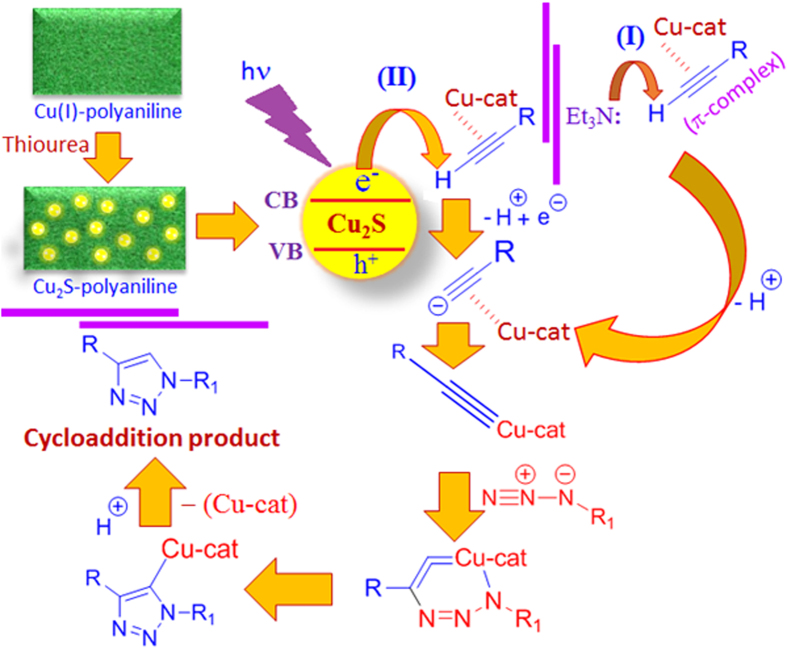
Schematic mechanism for the Cu2S catalysed azide-alkyne cycloaddition reaction in presence of base, Et3N, (I) and under UV or daylight irradiation (II) condition.